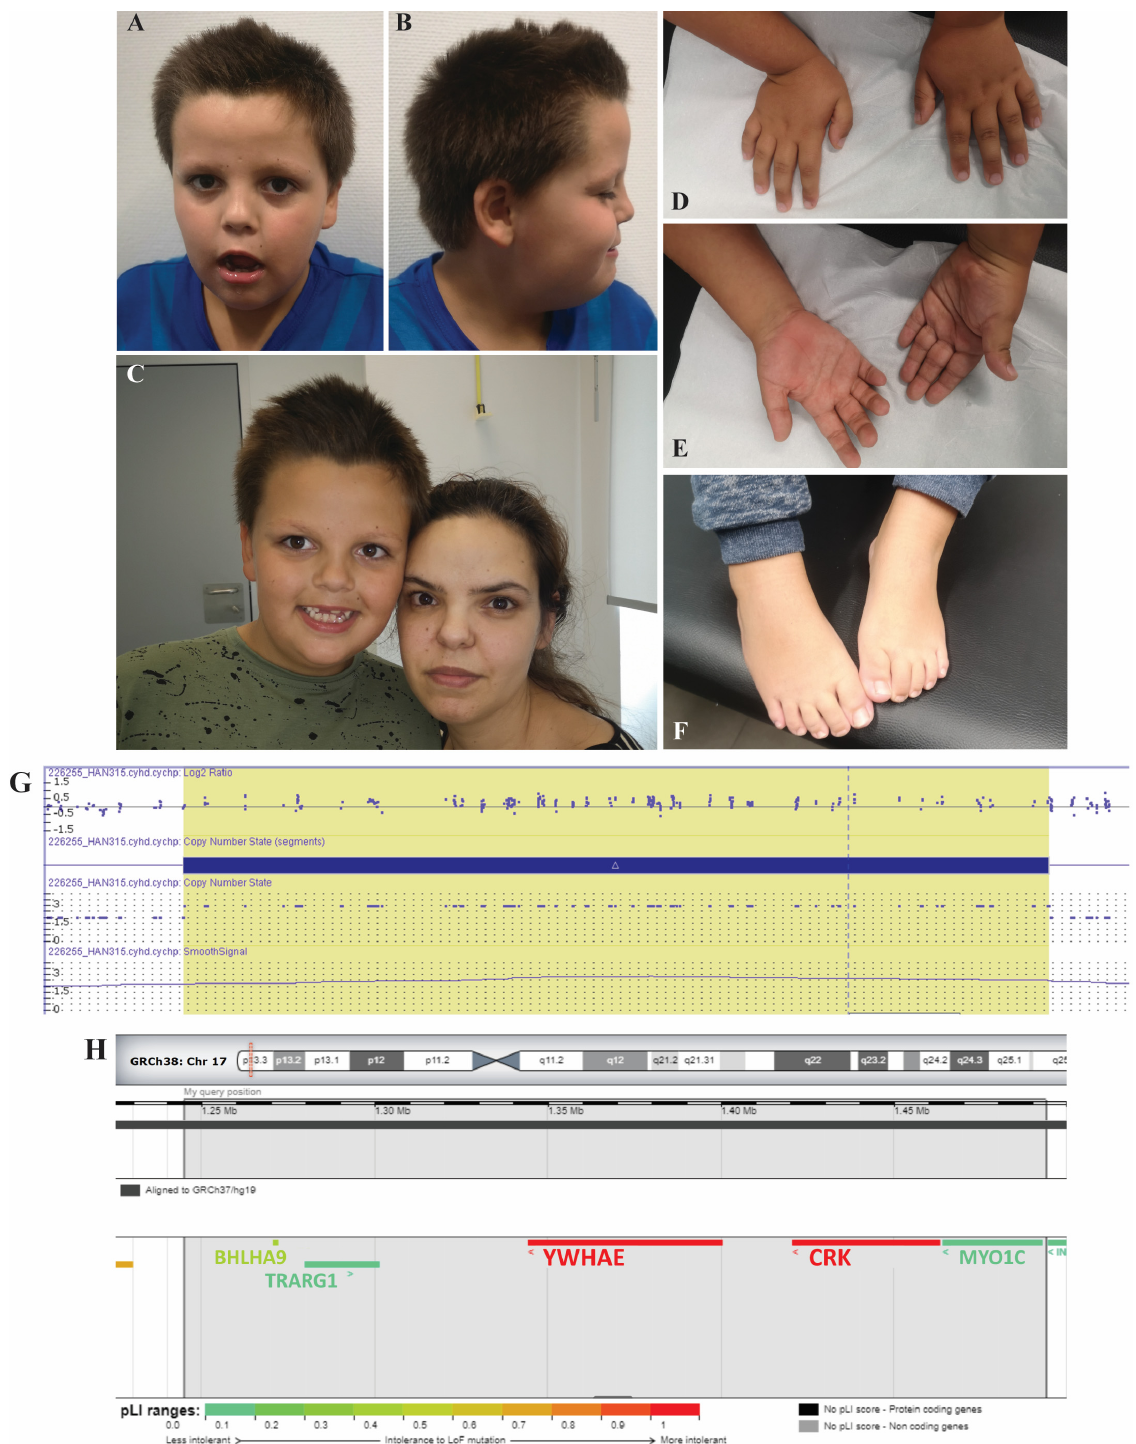
Figure 1. ( A , B ) Photographs of the proband to show dysmorphic features. ( C ) Photograph of the proband and its affected mother. ( D – F ) Photographs of the hands and feet of the proband. It is noteworthy the absence of any evident split hand/foot malformation. ( G ) Graphical representation of the array − CGH assay of the proband, depicting the duplicated segment, using the Affymetrix ® Chromosome Analysis Suite (ChAS) v4.0.0.385 (r28959) with NetAffx 33.2 (hg19). ( H ) Genomic map of the duplicated region and the respective affected genes. The color scale shows the pLI (probability of being loss − of − function intolerant) for each individual gene. Adapted from DECIPHER [7].